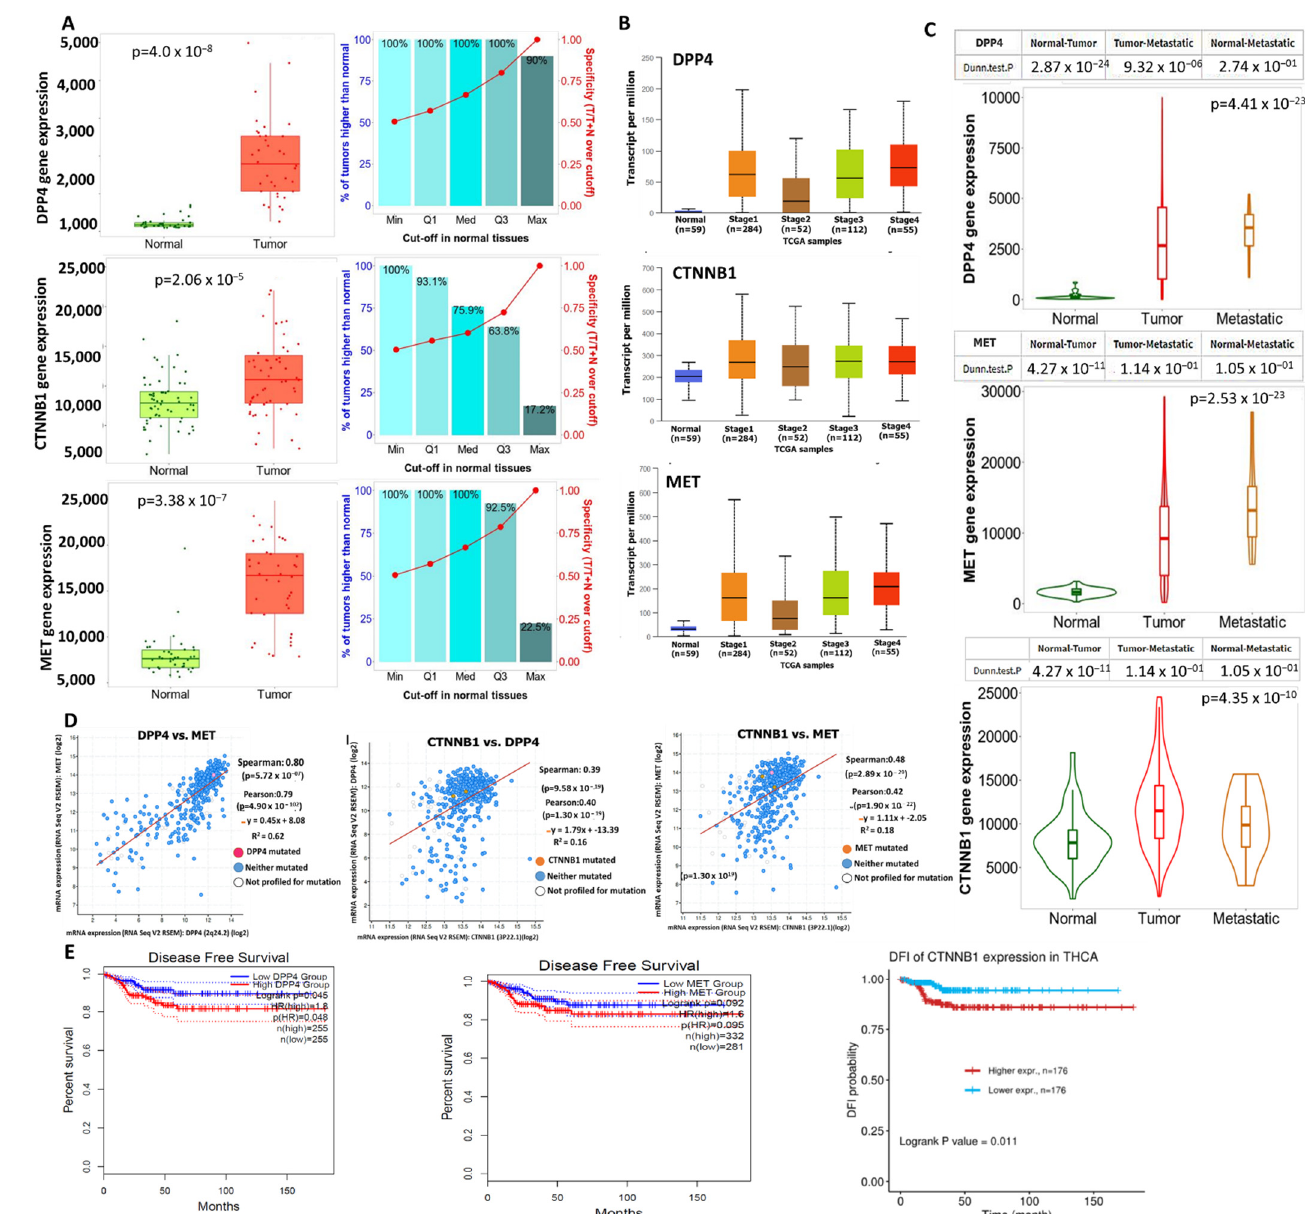
Figure 2. Overexpression of DPP4/CTNNB1/MET mRNAs, associated with thyroid cancer (THCA) progression. Differential expression levels of DPP4/CTNNB1/MET between ( A ) THCA tumor and adjacent normal tissue, ( B ) tumor stages, and ( C ) between primary and metastatic tumor of TCGA cohort. ( D ) Correlations of DPP4 with MET, CTNNB1 with DPP4, and MET with CTNNB1 oncogenic expressions in THCA. ( E ) KPM plots of survival ratio between THCA cohorts with high and those with low expression levels of DPP4/CTNNB1/MET .